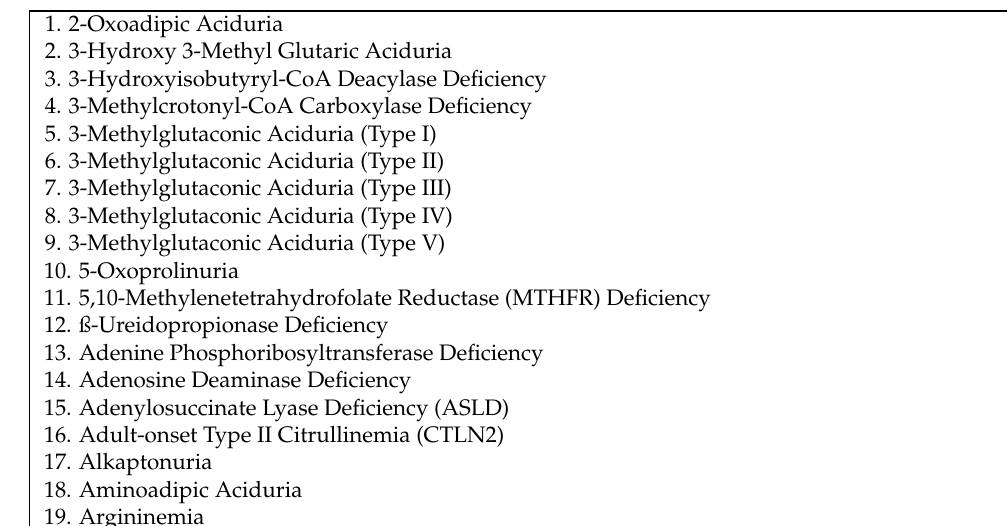
Table A2. A list of conditions screened by the urine